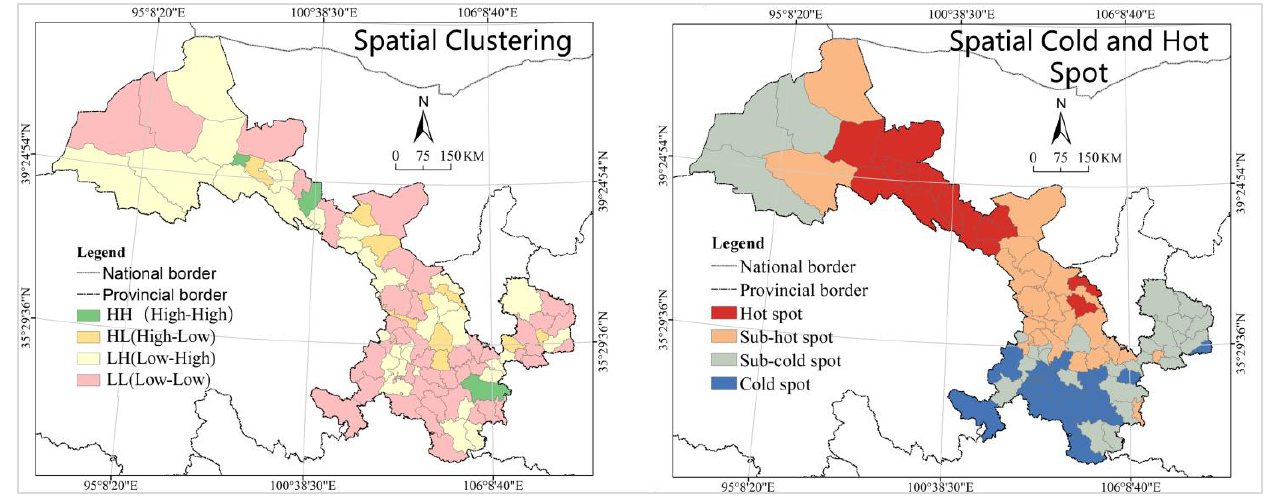
Figure 8. Analysis on the evolution trend of urban construction land in Gansu.